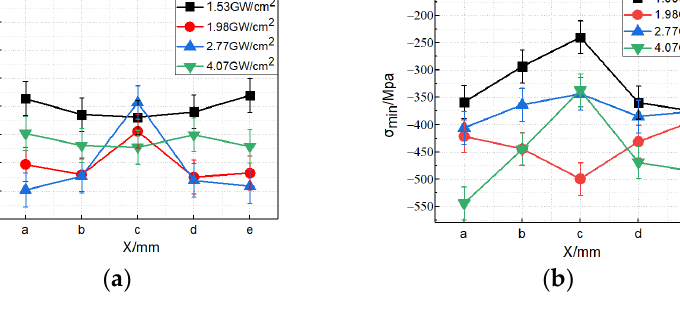
( a ) Maximum residual principal stress distribution. ( b ) Minimum residual principal stress distribution. ( c ) Principal stress direction angular distribution.